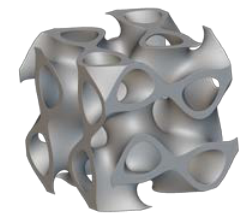
Figure 4. Unit cell of the Split P-TPMS.